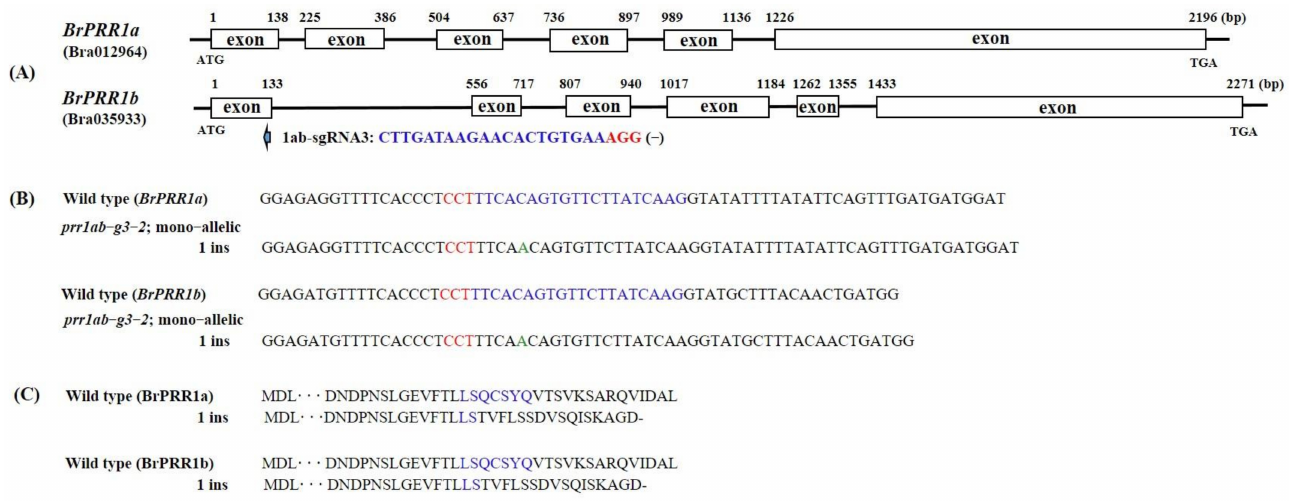
Figure 4. Genome editing of the Chinese cabbage BrPRR1a and 1b genes. Design of sgRNA sites for BrPRR1a and 1b exons. The PAM motif (NGG) is shown in red ( A ). NGS alignment of the sgRNA target region in different mutant lines. Deletions and insertions are indicated by dashes and green letters, respectively ( B ). Amino acid sequences of wildtype and generated mutations are shown ( C ). The sgRNA and PAM sites are represented in blue and red. Stop codon is shown with black